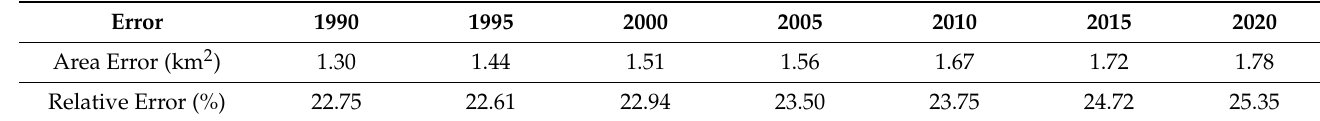
Table 1. Glacial lake area errors and average relative errors in the HKH-TMHA region from 1990–2020.